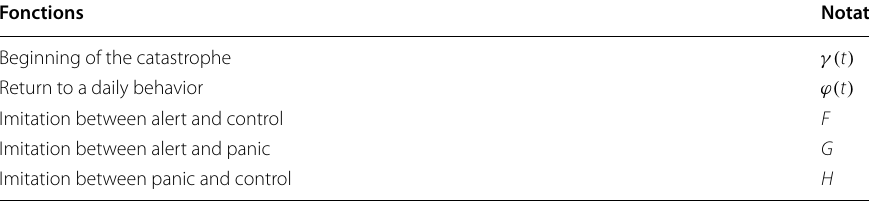
Table 2 Fonctions of the APC model